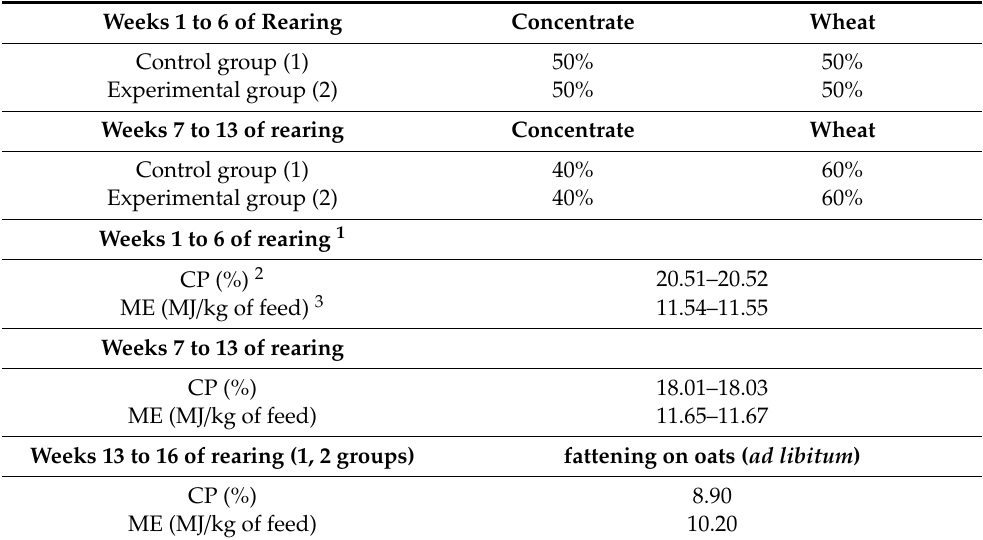
Table 1. Proportion of concentrate and wheat in feed for geese.